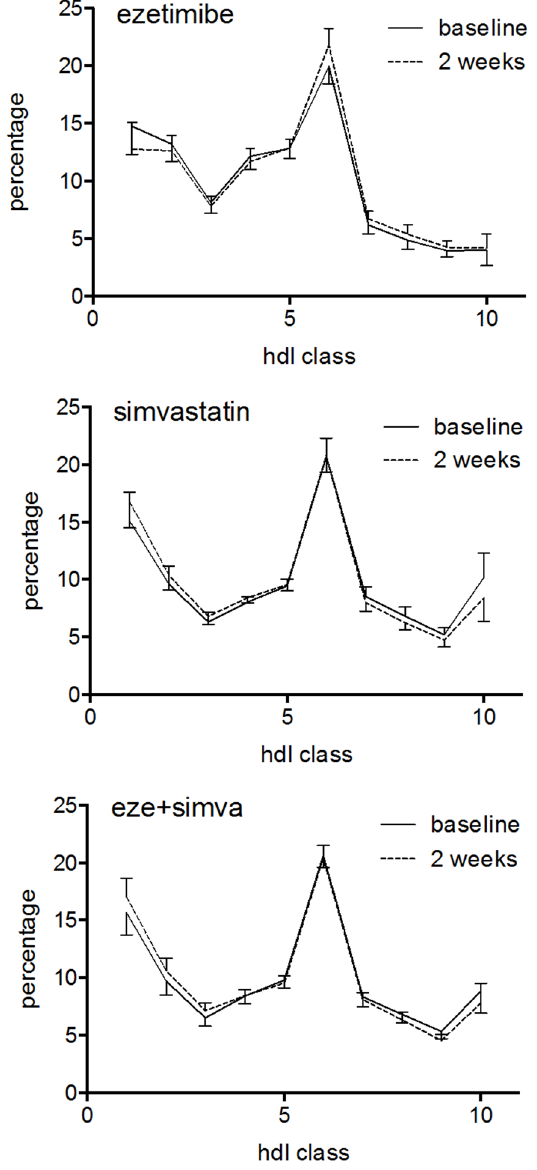
Figure 2. HDL subclass distribution before (solid line) and after 2 weeks of treatment (dotted lines). The data are means (95% confidence intervals) of the percentage of total HDL cholesterol. (A) ezetimibe, (B) simvastatin, (C) ezetimibe plus